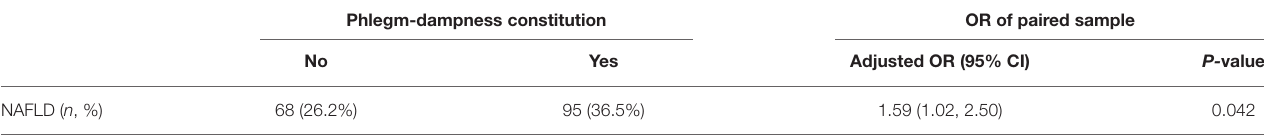
TABLE 5 | Prevalence of non-alcoholic fatty liver disease in non-phlegm-dampness and phlegm-dampness constitution group after matching among 1,677 participants. Phlegm-dampness